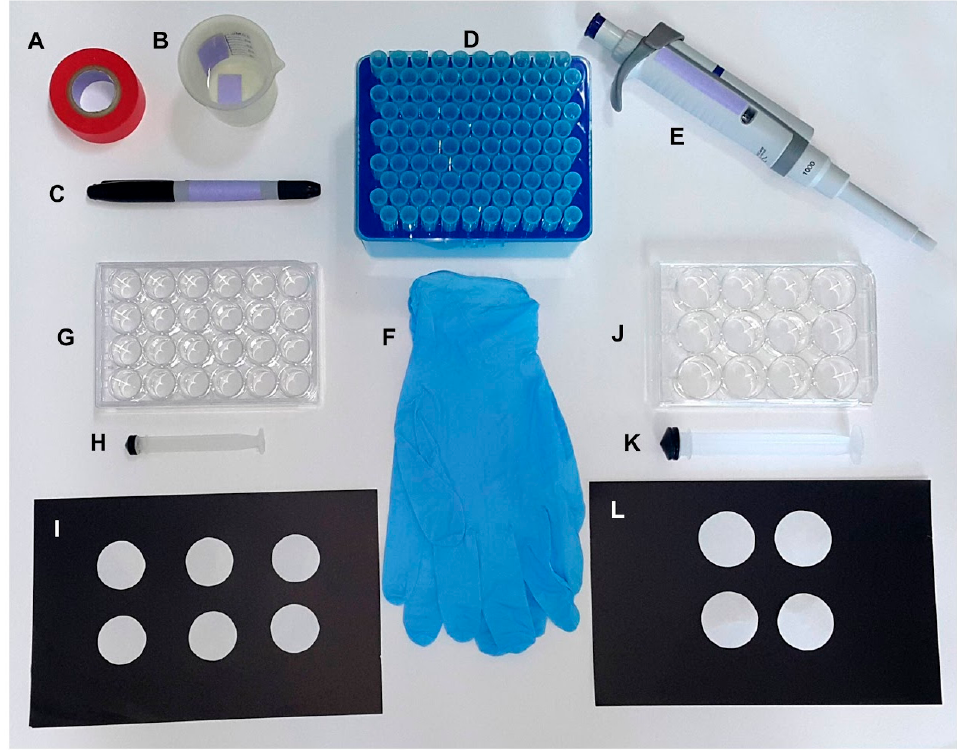
Figure 1. Materials required to set up the oviplates with 12- and 24-well cell culture plates. General materials for both oviplates: ( A ) tape; ( B ) tap water; ( C ) permanent marker; ( D ) 1.0 mL disposable tips; ( E ) p1000 pipette; ( F ) gloves. Specific materials for individual oviposition using 24 females: ( G ) 24-well cell culture plate; ( H ) 5.0 mL syringe plunger; ( I ) Circular filter paper with 2.0 cm diameter. Specific materials for individual oviposition using 12 females: ( J ) 12-well cell culture plate; ( K ) 20.0 mL syringe plunger; ( L ) Circular filter paper with 2.5 cm diameter.